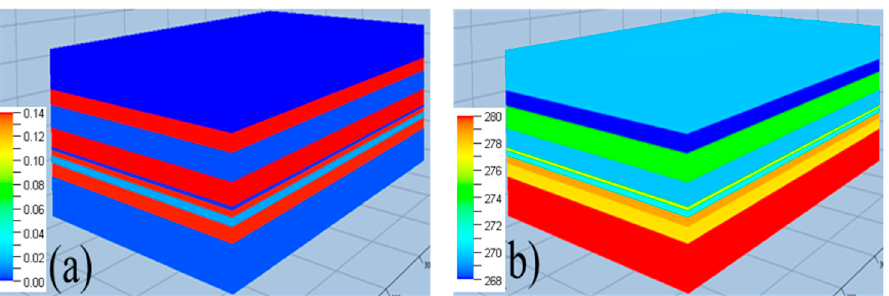
Figure 13. Heterogeneous numerical simulation model properties. ( a ) Porosity model; ( b ) minimum horizontal principal stress model.